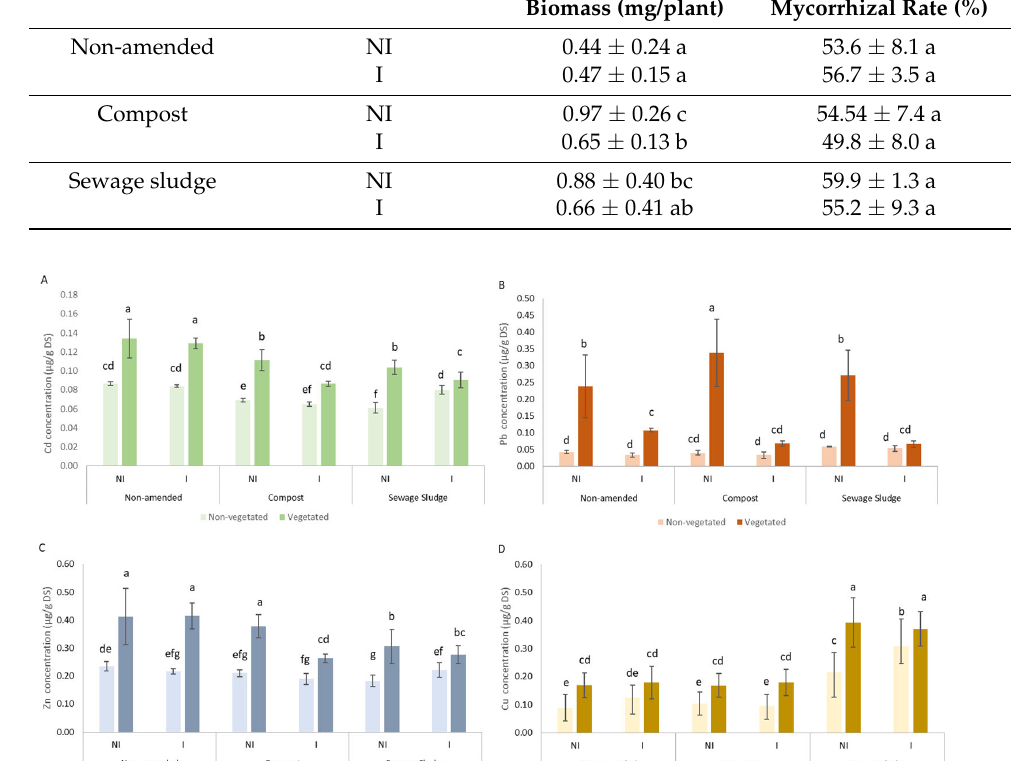
Figure 1. NH 4 NO 3 -extractable concentrations ( µ g/g dry soil (DS)) of Cd ( A ), Pb ( B ), Zn ( C ), and Cu ( D ) in soil amended or not (unamended) with compost or sewage sludge in the presence (I) or not (NI) of arbuscular mycorrhizal inoculum. Significant differences between conditions are indicated by different letters at the level of α = 0.05.